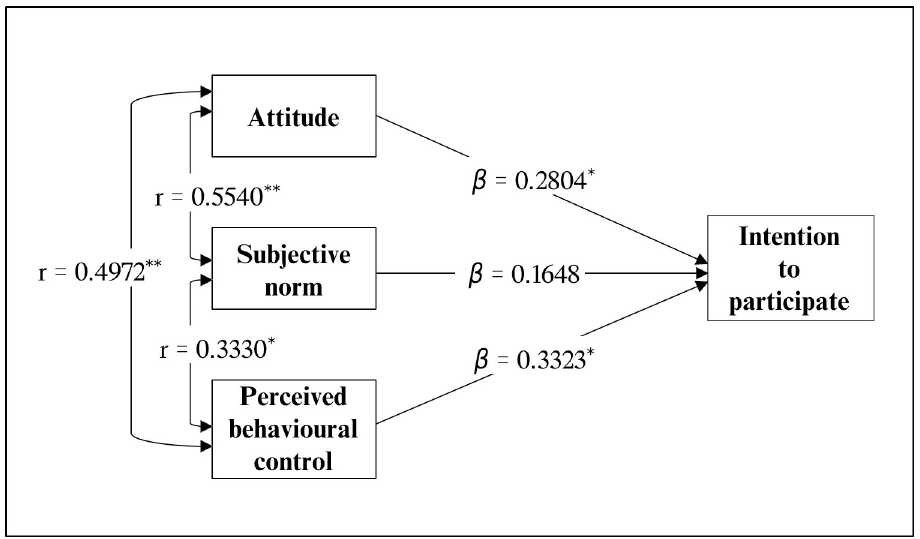
Fig 3. Path model–the relationship between attitude, subjective norm, perceived behavioural control with intention to participate. Note: All parameter values are standardised; � p < .05, �� p < .001; r–correlation coefficients; β –regression coefficients, the outcome variable increases β times for every unit increase in a predictor